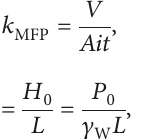
Table 6: The index properties of the Pb(NO